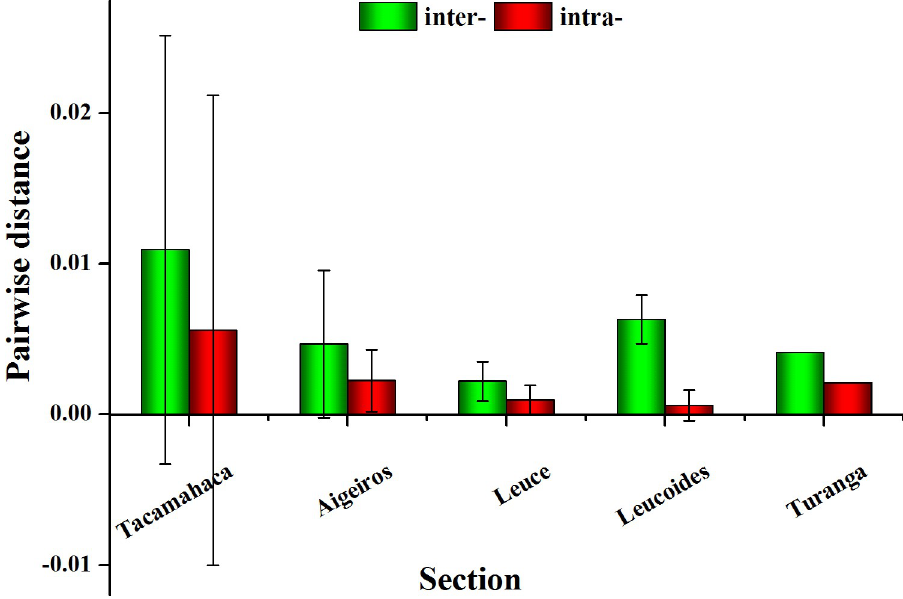
Fig 2. Average inter- and intraspecific pairwise distances for each section using the ITS